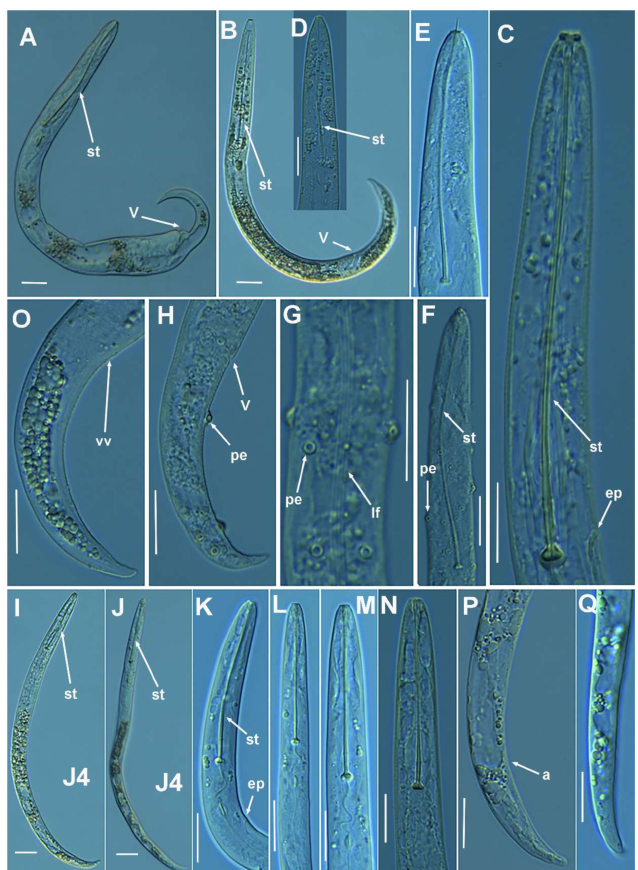
Figure 13. Light photomicrographs of Paratylenchus verus (Brzeski, 1995) Brzeski, 1998. ( A , B ) Entire female with stylet and vulva arrowed; ( C – F ) female lip region with stylet, excretory pore and Pasteuria endospore arrowed; ( G ) detail of lateral field at mid-body and Pasteuria endospore arrowed; ( H ) female posterior region with vulva and Pasteuria endospore arrowed; ( I , J ) entire fourth-stage juvenile with stylet arrowed; ( K – N ) fourth-stage juvenile lip region with stylet and excretory pore arrowed; ( O ) fourth-stage juvenile posterior region with vaginal vestigium arrowed; ( P , Q ) fourth- stage juvenile posterior region with anus arrowed. Scale bars ( A – Q = 20 µ m). (Abbreviations: a = anus; ep = excretory pore; lf = lateral field; pe = Pasteuria endospore; st = stylet; vv = vaginal vestigium; V =